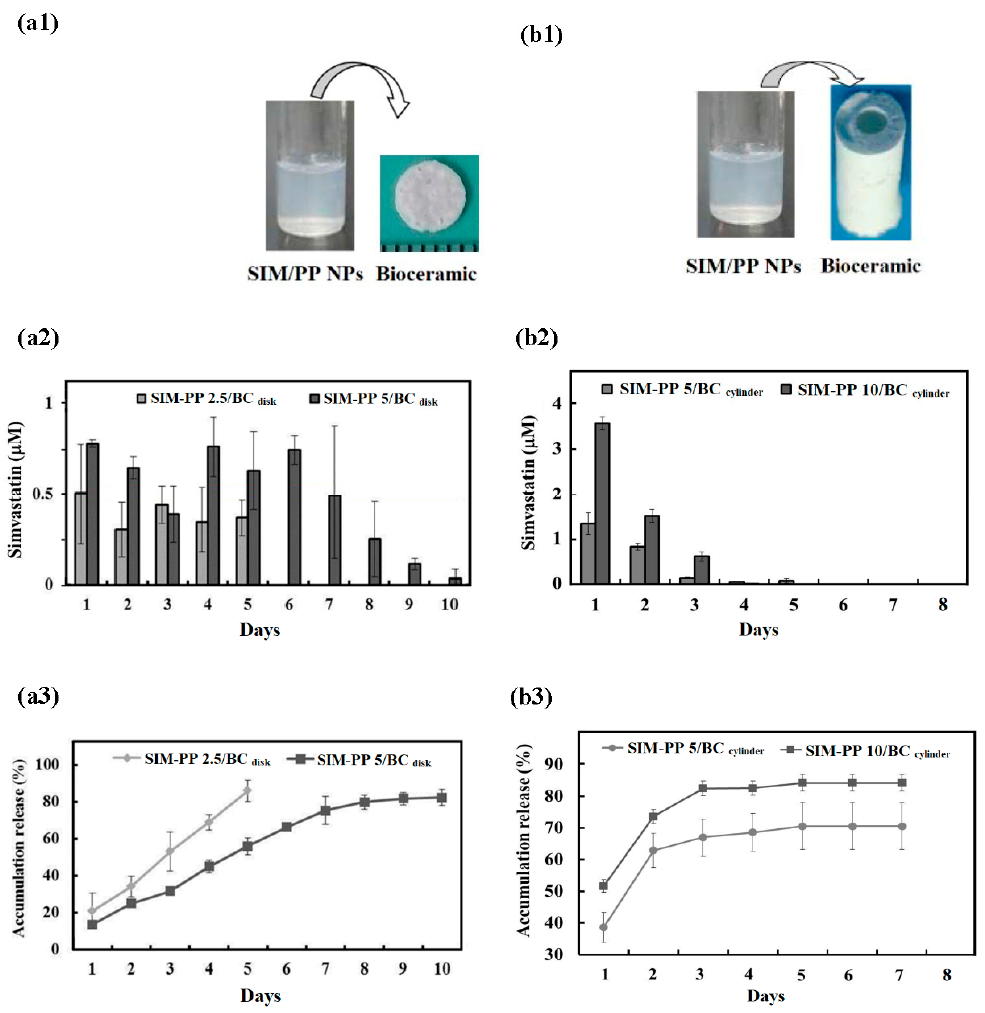
Figure 1. Two types of porous bioceramic samples are shown below: one is disk mold ( a1 , φ 5 mm; h 0.7 mm) and the other is hollow cylinder mold ( b1 , φ 1 3.5 mm; φ 2 1.5 mm; h 10 mm), these are all combined with SIM-PP nanoparticles and promote bone growth. Daily release profiles of the active form of simvastatin (act-SIM) measured by high-pressure liquid chromatography at 37 °C for 7–10 days. ( a2 ) SIM-PP NPs loaded within disk bioceramic samples ( φ 5 mm; h 0.7 mm; BC disk ). ( b2 ) SIM-PP NPs loaded within hollow cylinder bioceramic samples ( φ 1 3.5 mm; φ 2 1.5 mm; h 10 mm). ( a3 , b3 ) Average percentages of act-SIM cumulative release. Notes: SIM-PP NP 2.5/BC disk : the 2.5 μ g simvastatin loaded with disk bioceramic; SIM-PP NP 5/BC disk : the 5.0 μ g simvastatin loaded with disk bioceramic; SIM-PP NP 5/BC cylinder : the 5.0 μ g simvastatin loaded with hollow cylinder bioceramic; SIM-PP NP 10/BC cylinder : the 10.0 μ g simvastatin loaded with hollow cylinder bioceramic. Table 2. The phase ratio of HAp/ β -TCP, bulk density and porosity of the bioceramics after sintering at 1200 °C for 2 h. Phase ratio of HAp/ β -TCP Porosity (%) Bulk Density (g/cm 3 ) Phase Ratio of HAp/ β 50/50 56.29 ± 0.55